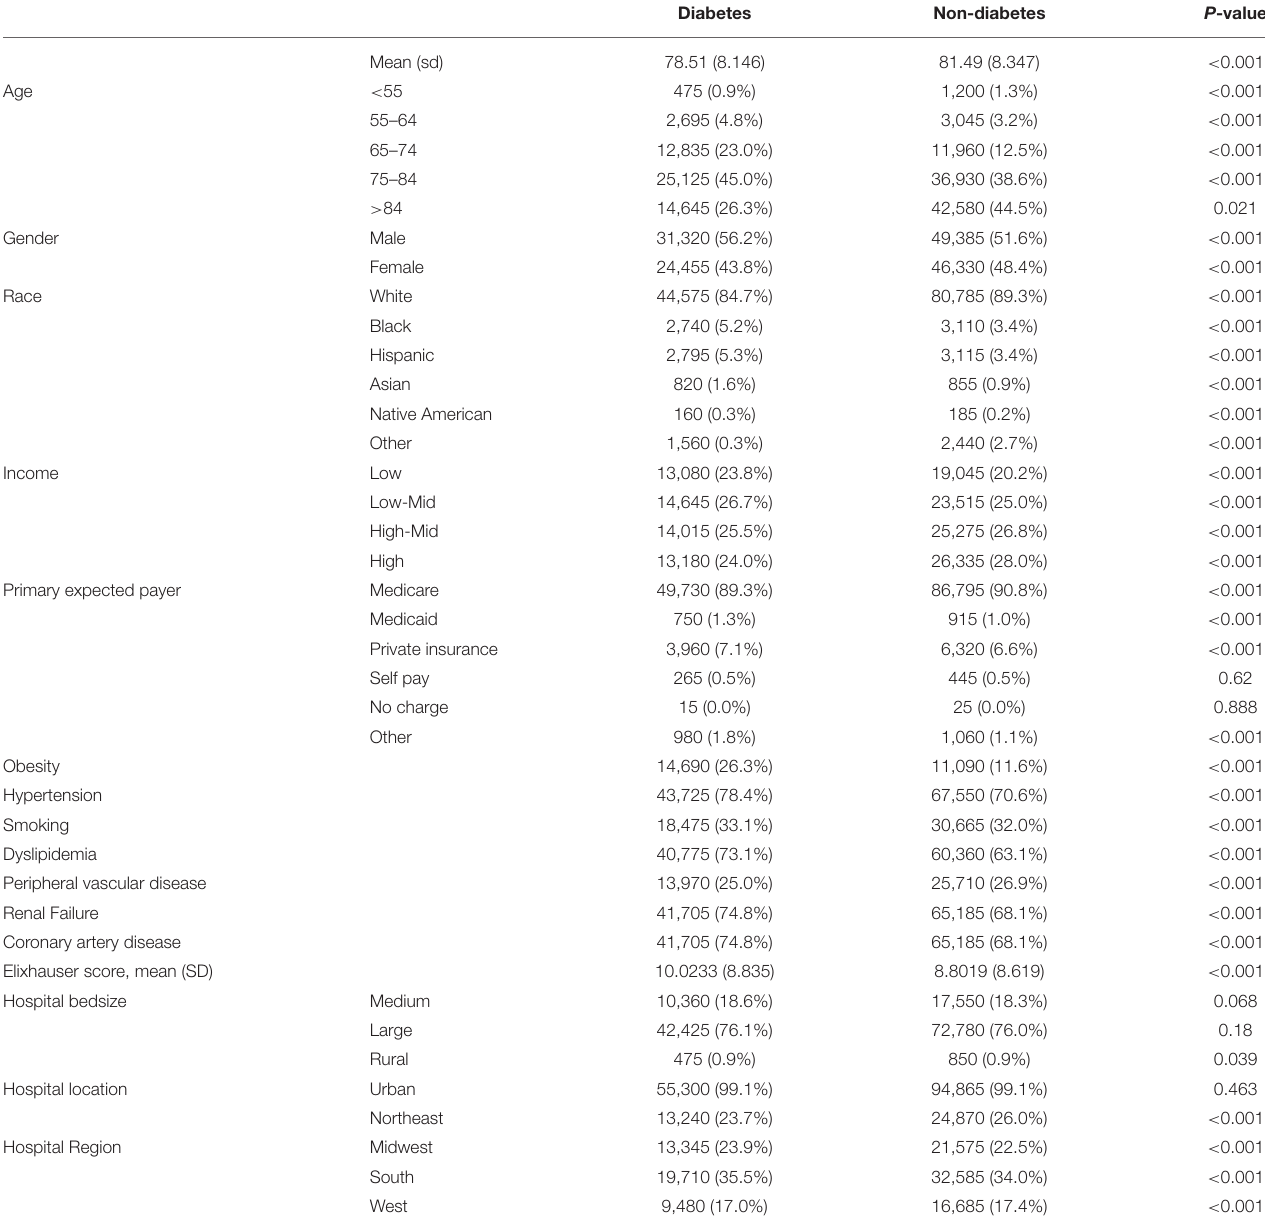
TABLE 2 | Comparison of patients with vs. without diabetes undergoing